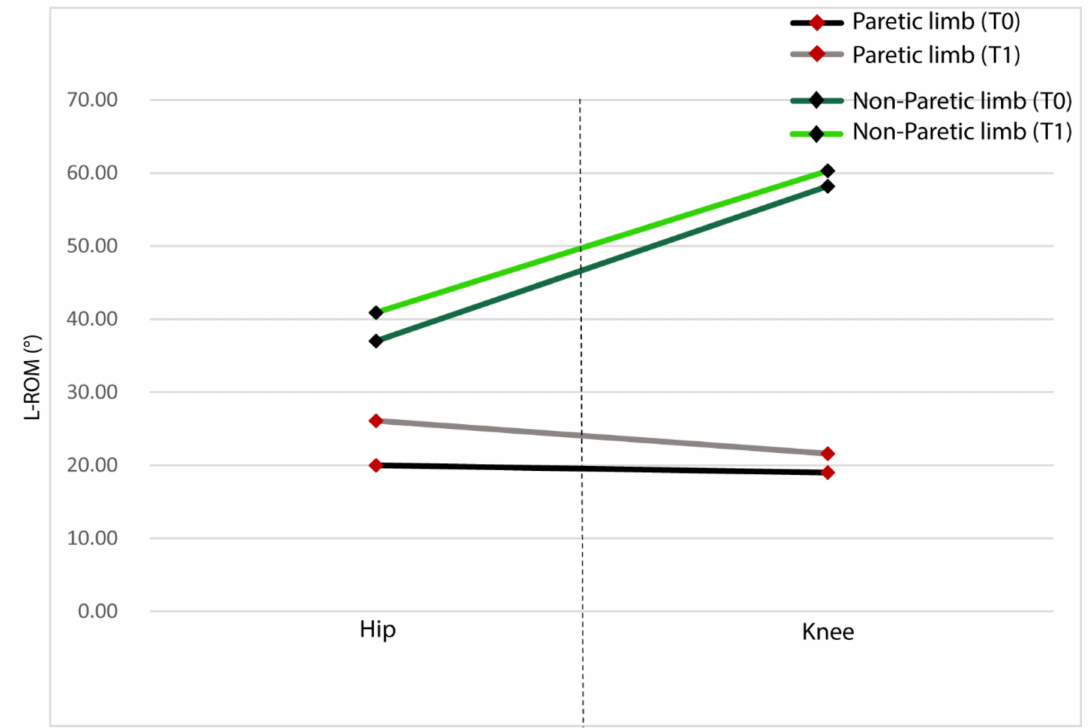
Figure 3. L-ROM (lower limb-range of motion) measures (mean) of paretic and non-paretic limb at basal assessments T0 and one-month follow-up